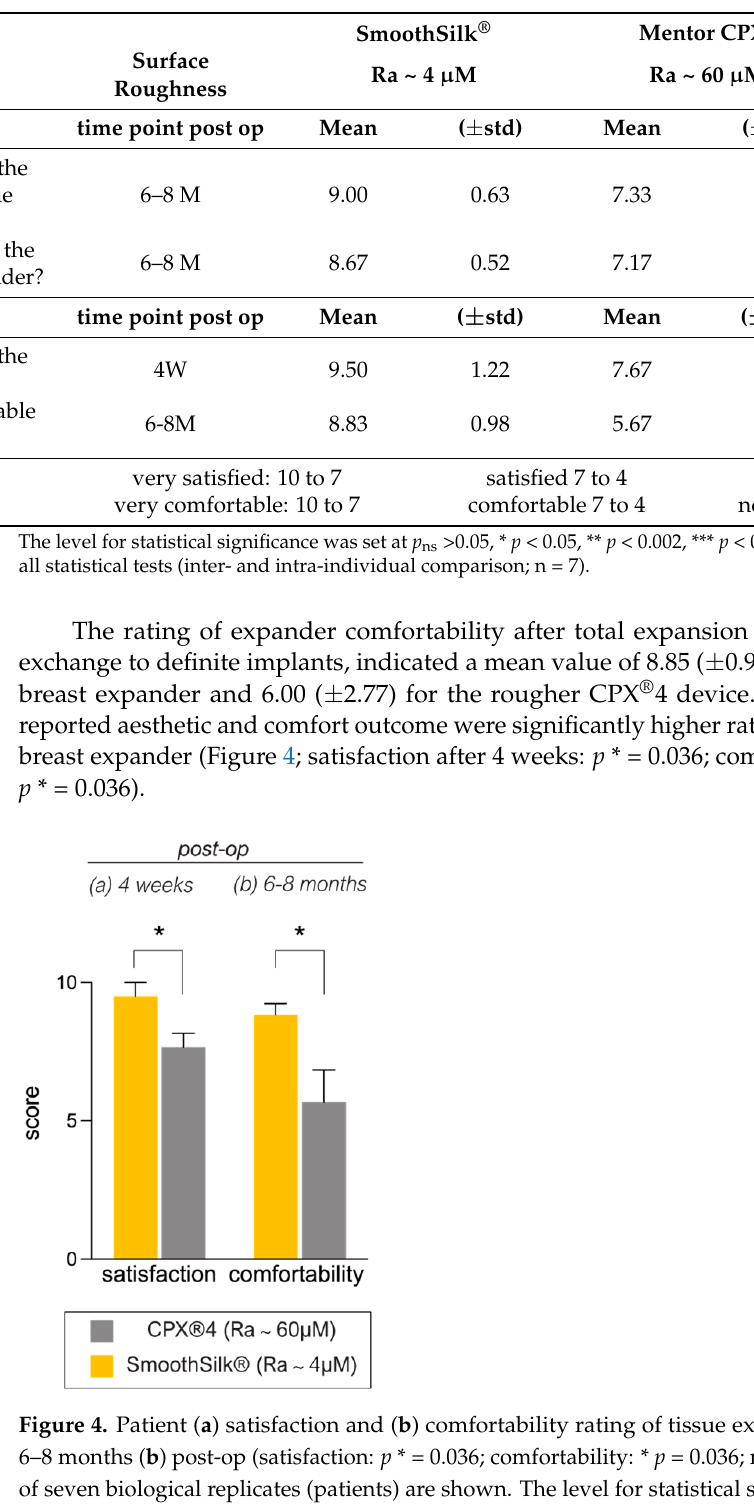
Table 6. Satisfaction questionnaire. Surgeon and patient scale of device aesthetic, practicability, and comfortability outcome satisfaction.